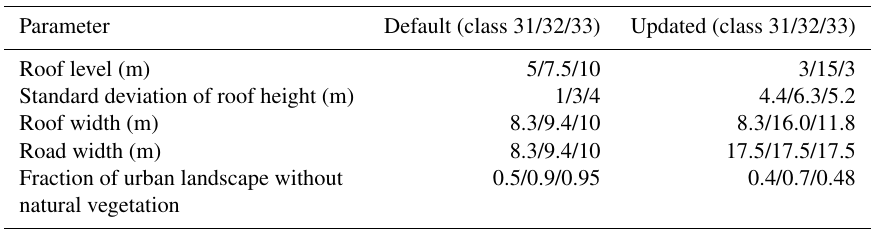
Table 2. Urban parameters for Berlin for the three urban classes low intensity residential (31), high intensity residential (32) and commer- cial/industry/transport